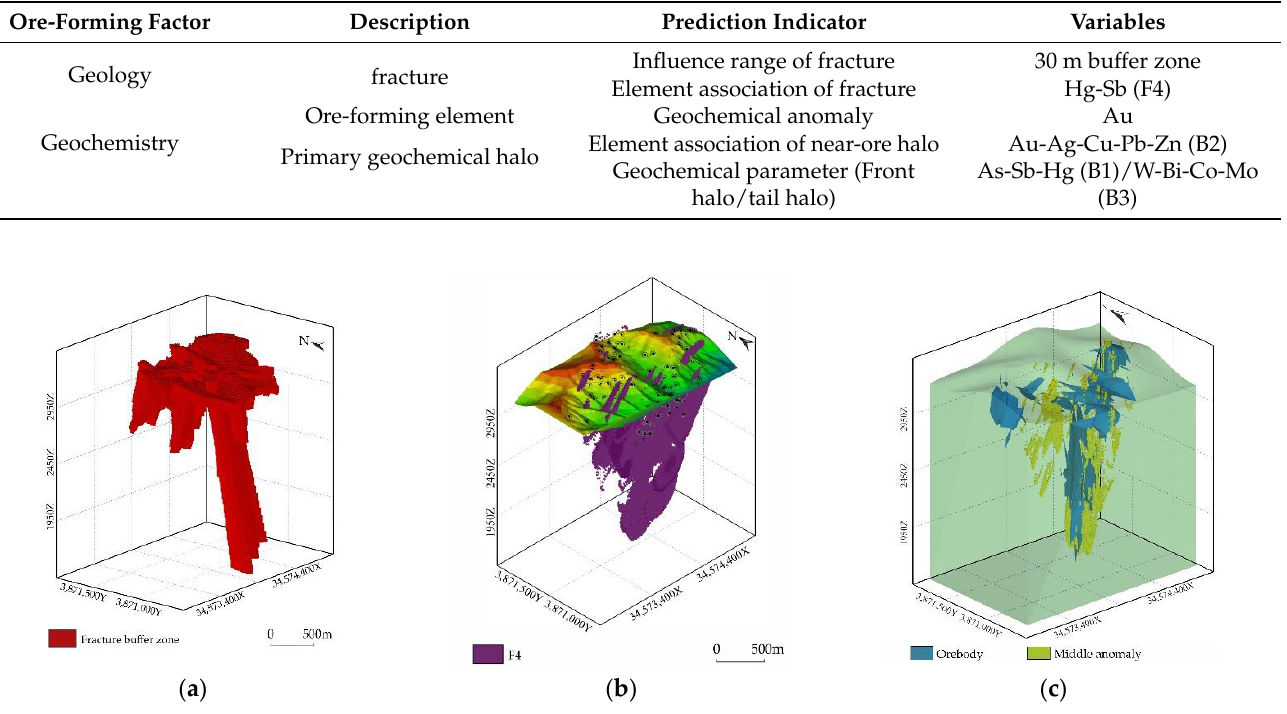
Table 1. Geological and geochemical quantitative mineral resource prediction model at depth of the Zaozigou gold deposit.